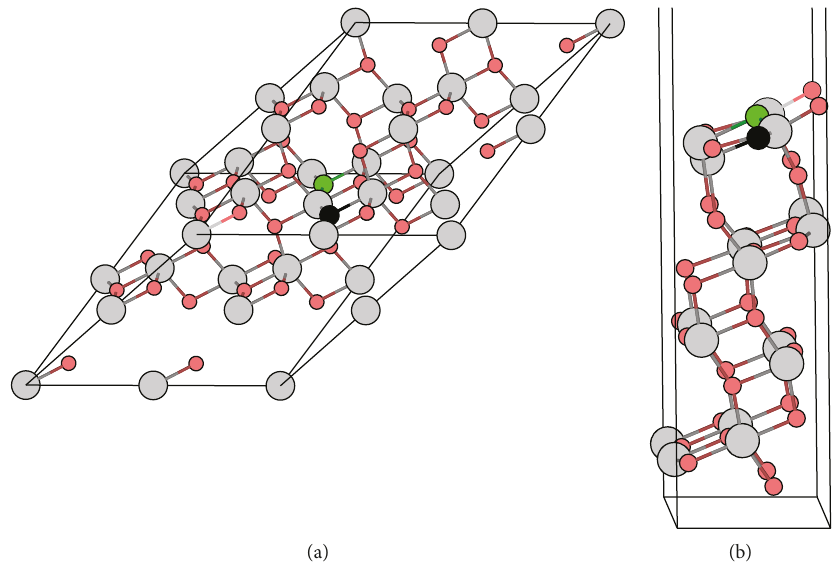
Figure 1: Doping sites on anatase TiO . (a) The 3 × 3 × 3 bulk supercell. (b) The 2 × 1 × 1 surface in the (101) direction with four layers. Both 2 models constituted by 48 atoms. One three-coordinated O atom was replaced by C, N, S, or F atom. Red balls are O atoms; gray ones are Ti. Black balls indicate the substitution site, and green balls show the oxygen